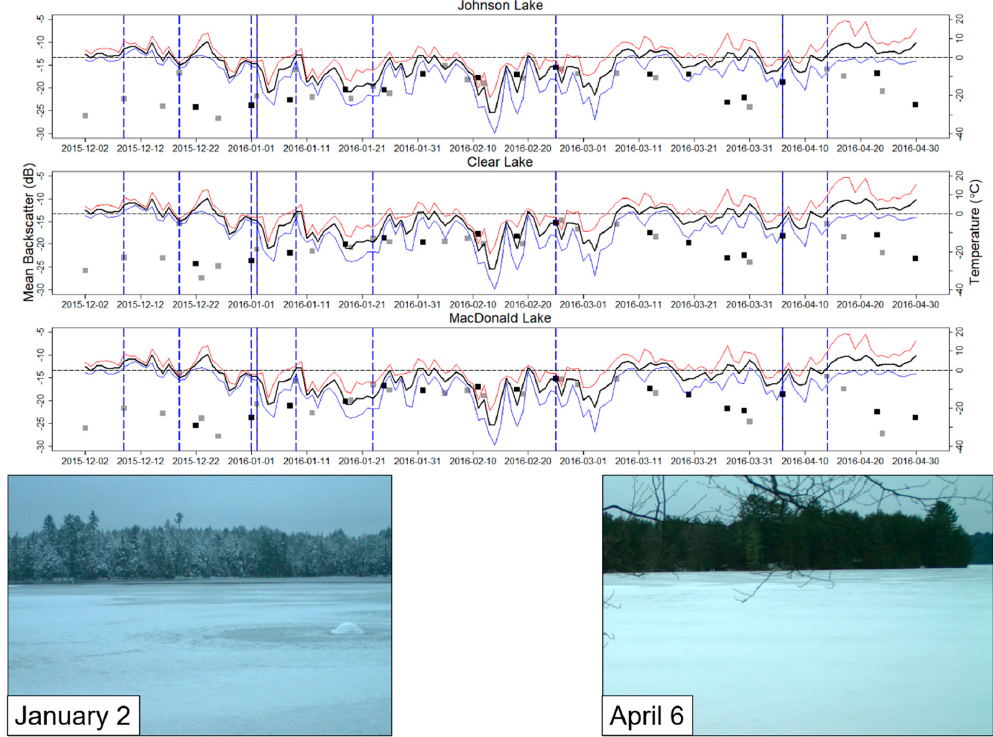
Figure 6. Backscatter and temperature evolution for the 2015/2016 ice season. Black squares represent images that were acquired in the PM and grey squares represent images acquired in the AM. The blue lines indicate when a major freezing event was determined and the solid lines are the dates of the sample images. The two images are from the lake ice monitoring network on MacDonald Lake and display the surface conditions corresponding to the respective event.